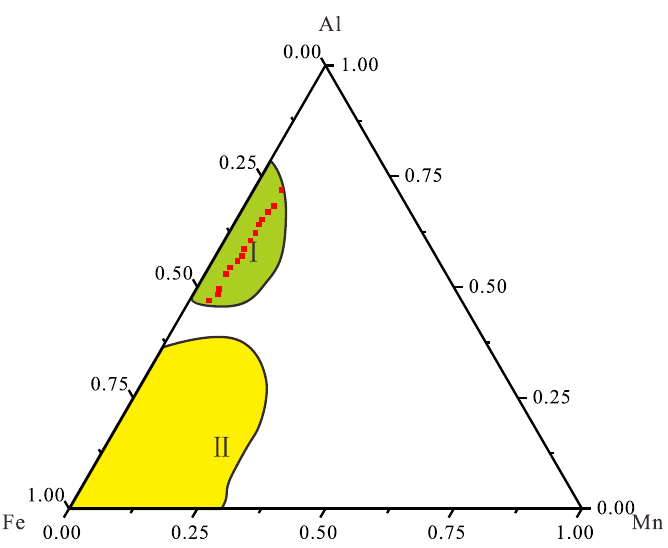
Figure 3. Through the Al-Fe-Mn ternary plot analysis, siliceous minerals from the Upper Ordovician Wufeng Formation – Lower Silurian no. 1 section of the Longmaxi Formation in Jiaoye-1 well contains excess siliceous minerals, which are derived from bio-origins. The base map is from Wedepohl [26], Adachi et al. [27], and Yamamoto [46]. See Figure 1 for the well location. I: bio-origin, II: hydrothermal